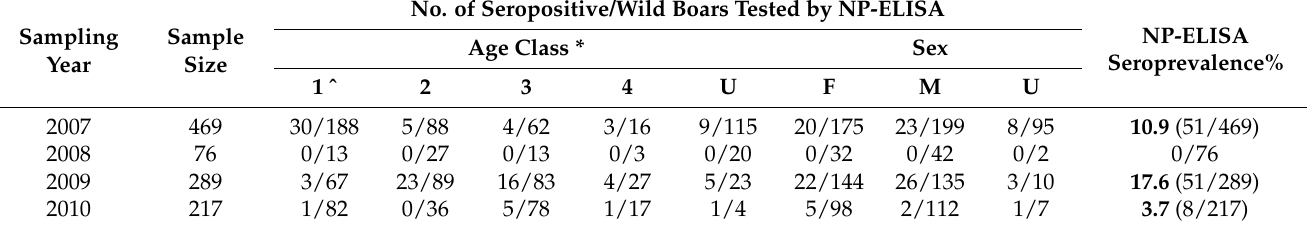
Table 1. Overall results from wild boars ( Sus scrofa ) tested for the occurrence of influenza A virus exposure in an anthropized area of Northern Italy